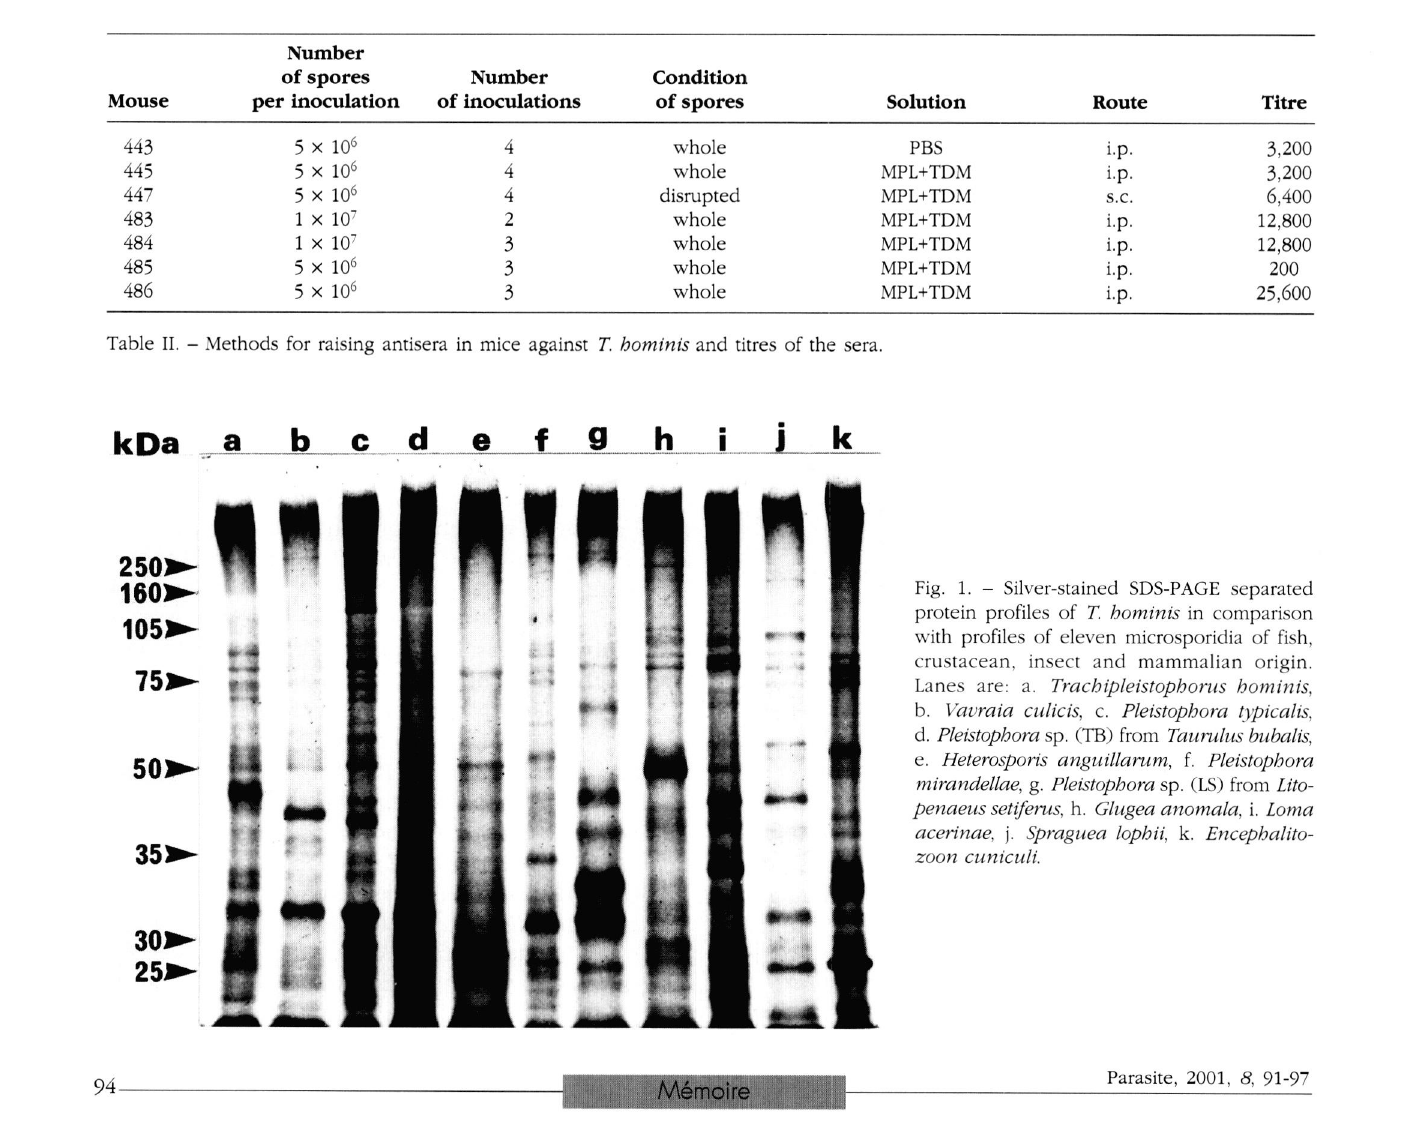
Fig. 1. - Silver-stained SDS-PAGE separated protein profiles of T. hominis in comparison with profiles of eleven microsporidia of fish, crustacean, insect and mammalian origin. Lanes are: a.